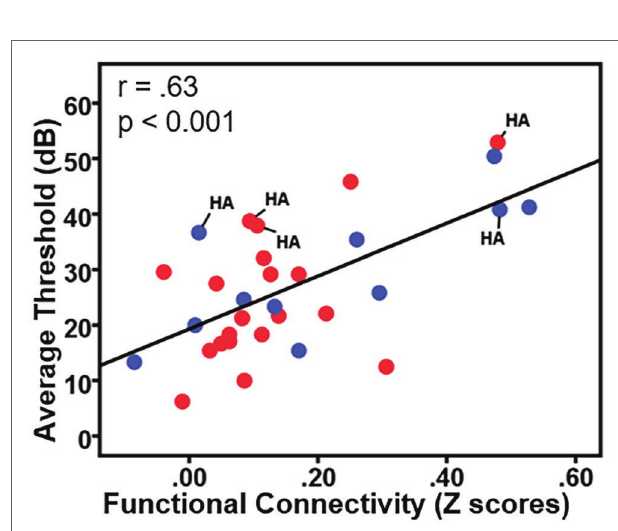
FIGURE 4 | Plot of the correlation between participant hearing ability (i.e., the average threshold 0.250–0.8 kHz in dB from both ears) and the functional connectivity between right Heschl’s gyrus and the dorsal anterior cingulate. Red circles = females; blue circles = males; HA = hearing aid